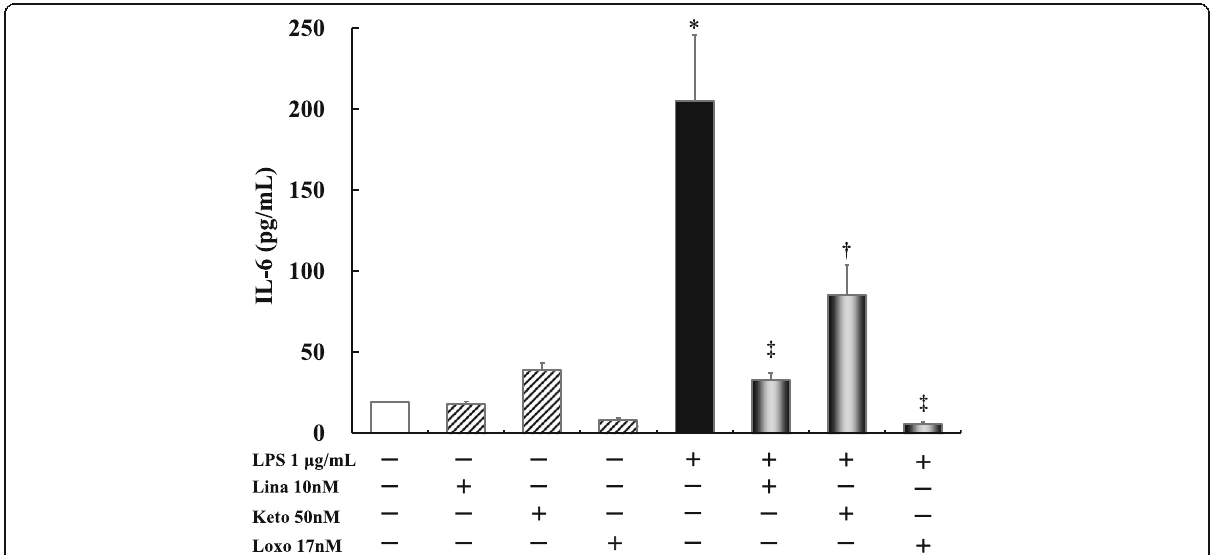
Fig. 2 Effects of linagliptin, ketoprofen, or Loxo treatment on LPS-induced IL-6 production after 24 h. Human U937 monocytes were treated with LPS and/ or linagliptin, ketoprofen, or Loxo. IL-6 levels in the supernatants were determined via ELISA after 24 h of treatment. * P <0.0001 vs. control; † P <0.001 vs.